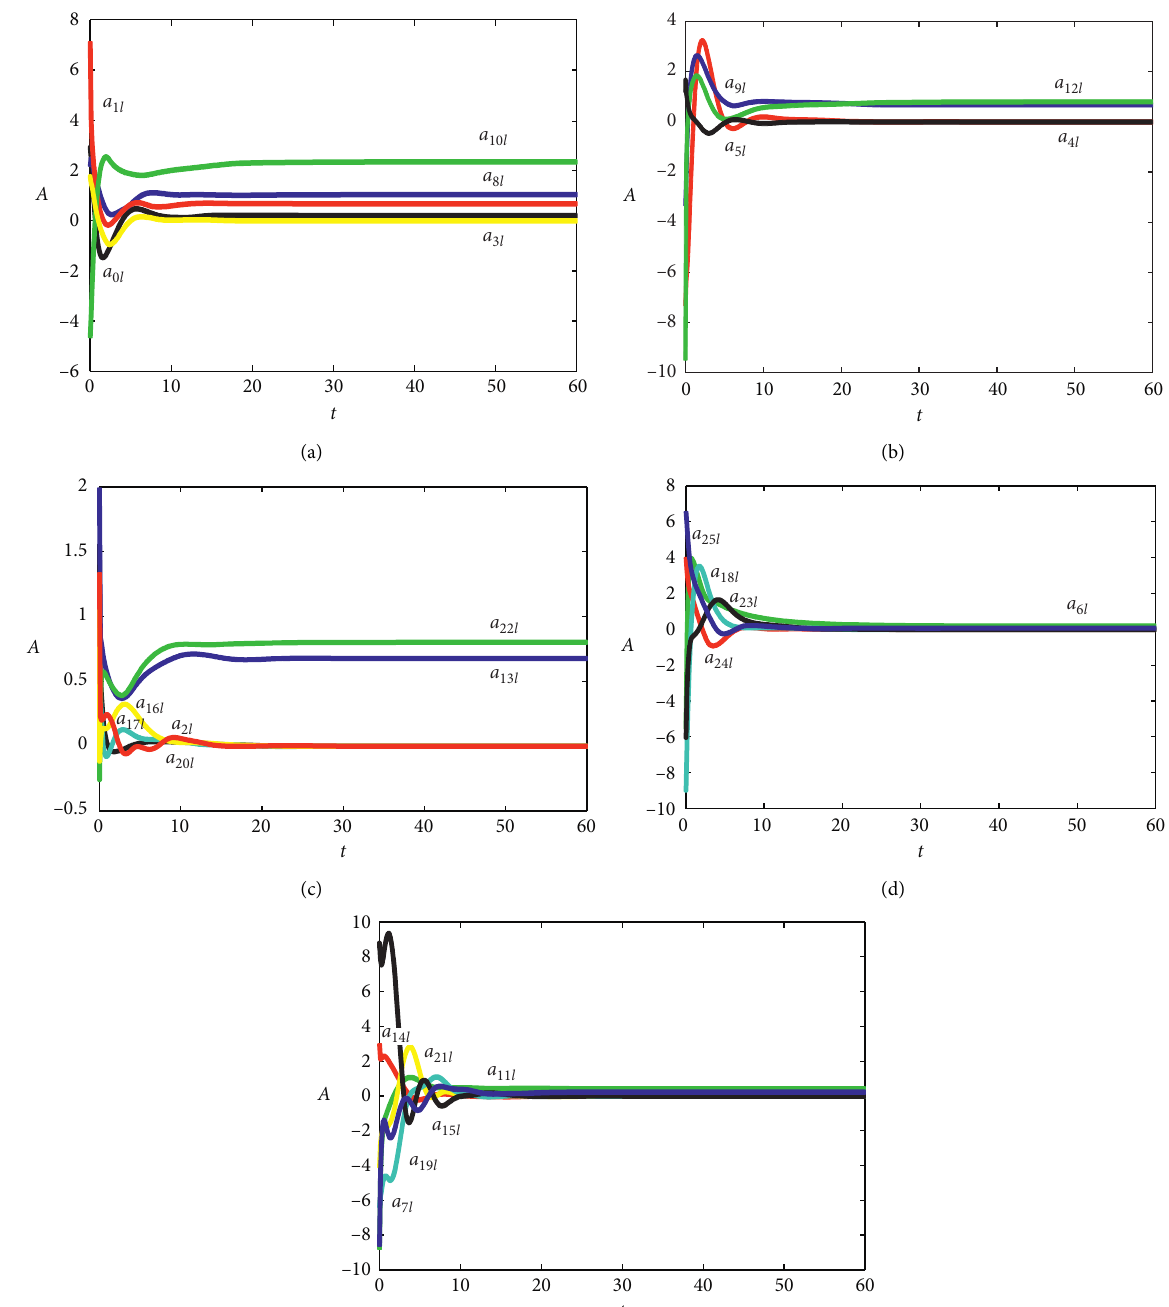
Figure 3: Transient behaviors of a